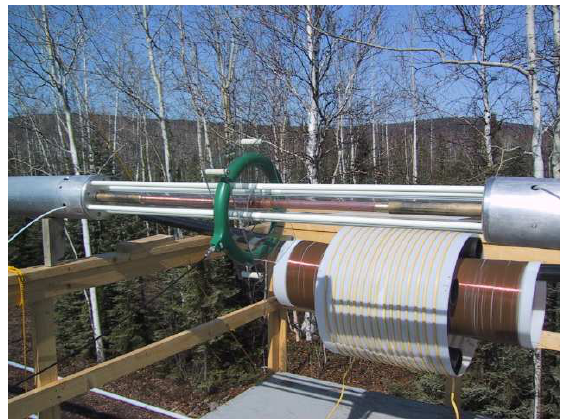
Fig. 2. Center of the 2.85-MHz Hertz dipole, seen in Fig. 1, show- ing the self firing pressurized SF 6 spark gap, Tesla primary and sec- ondary antenna charging coils, and green antenna current monitor- ing transformer, surrounding the electrodes of the spark gap.